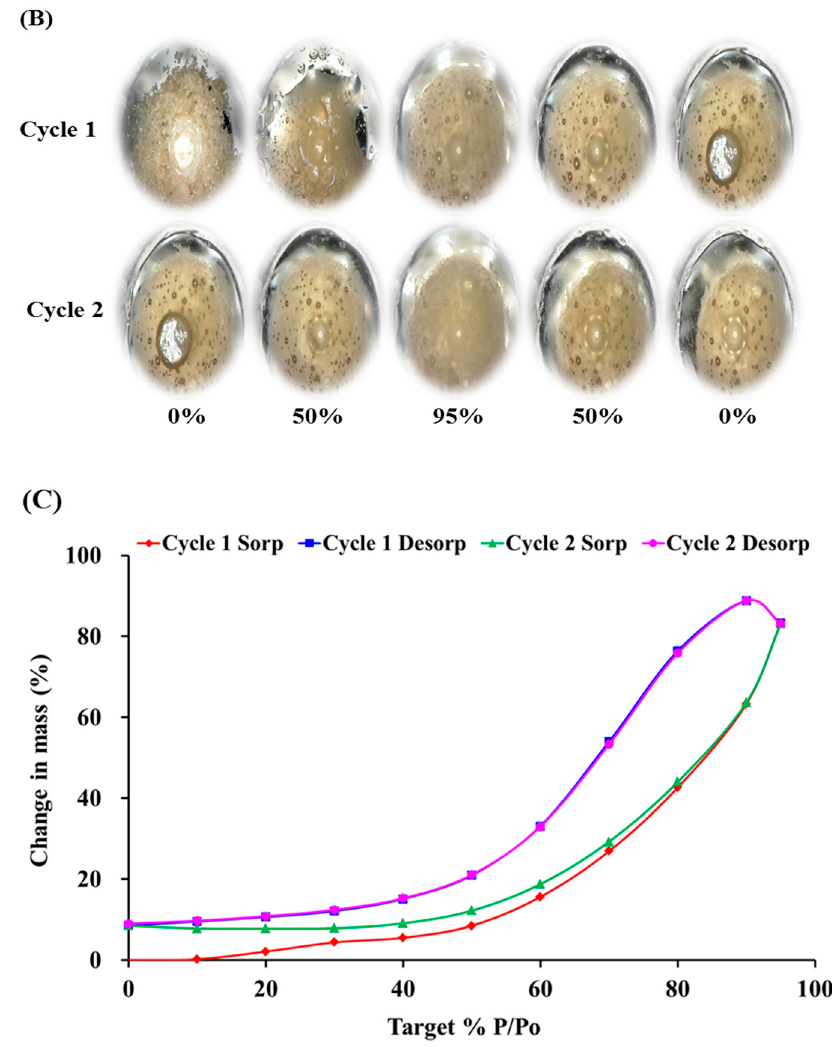
Figure 1. Dynamic vapor sorption measurements (from 0% to 95% RH) of SHs flour: ( A ) Water vapor sorption kinetic. ( B ) Changes of appearance shape. ( C ) Isotherm plot for SHs flour at 25 °C.